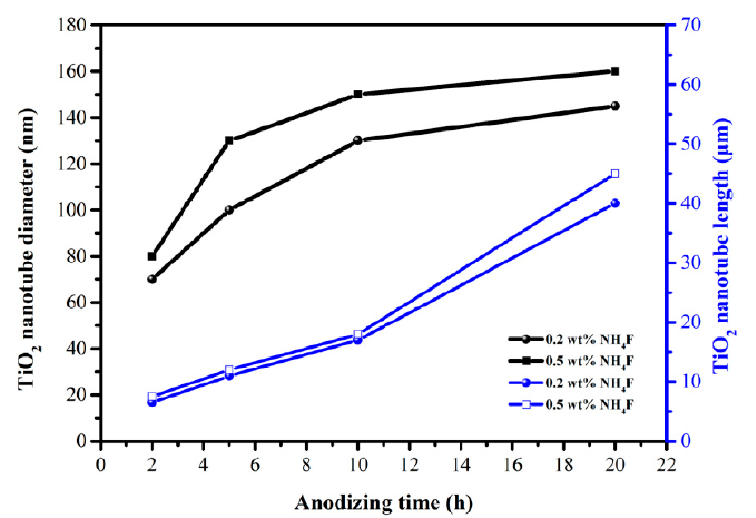
Figure 7. Comparison of TiO 2 nanotube diameters and lengths obtained under different anodizing times in electrolyte with 0.2 and 0.5 wt% NH 4